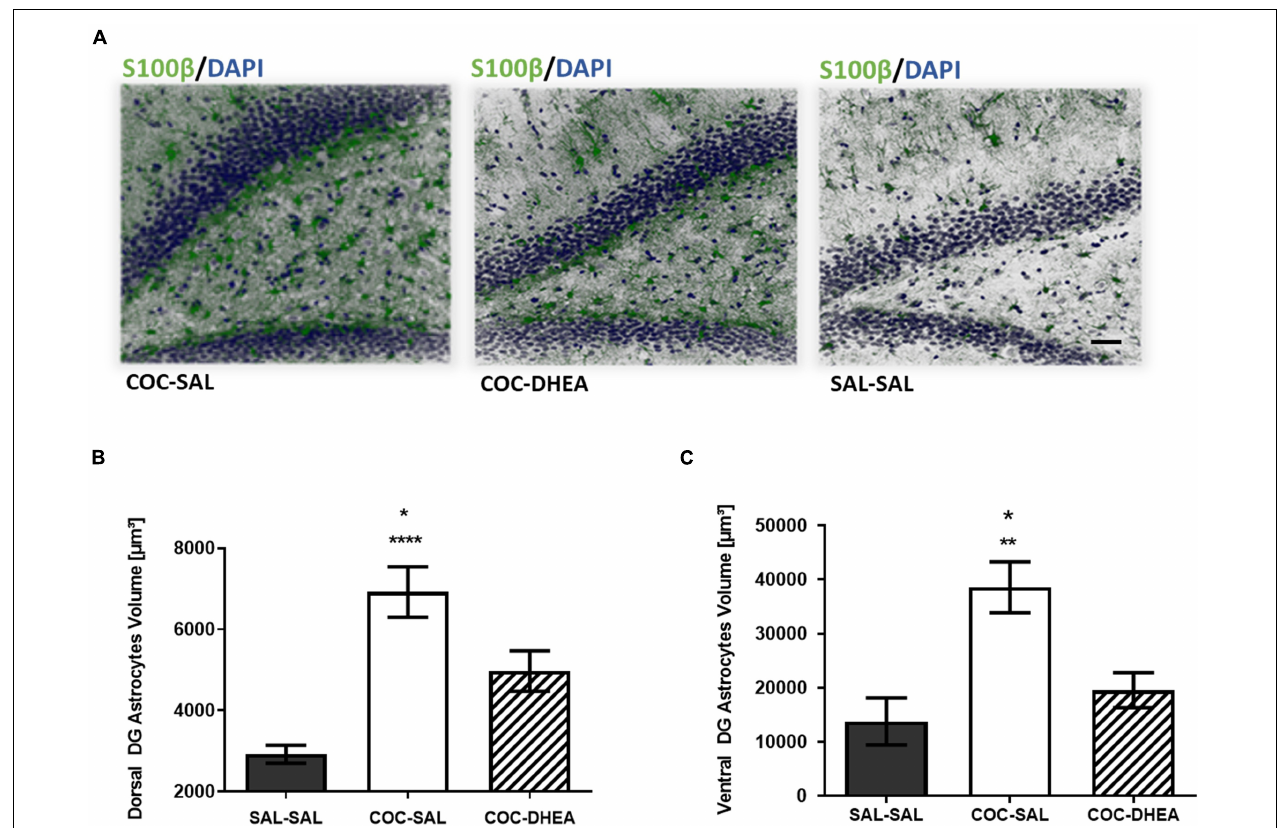
FIGURE 4 | The effect of DHEA treatment on dentate gyrus astrocytes. (A) Representative dorsal dentate gyrus images taken under a confocal microscope. Slices were immunohistochemically stained for s100 β protein (green) and DAPI (blue). (B,C) Quantification of S100 β expression in the dorsal and ventral dentate gyrus. One-way ANOVA of S100 β expression in all three groups revealed a significant effect between COC-DHEA vs. COC-SAL (* p < 0.05) and SAL-SAL vs. COC-SAL (**** p < 0.0001) groups in the dorsal dentate gyrus [ F (2,13) = 19.99; p < 0.001] and between COC-DHEA vs. COC-SAL (* p < 0.05) and SAL-SAL vs. COC-SAL (** p < 0.01) groups in the ventral dentate gyrus [ F (2,15) = 9.780; p < 0.01] ( n = 5–6, * Bonferroni’s multiple comparison